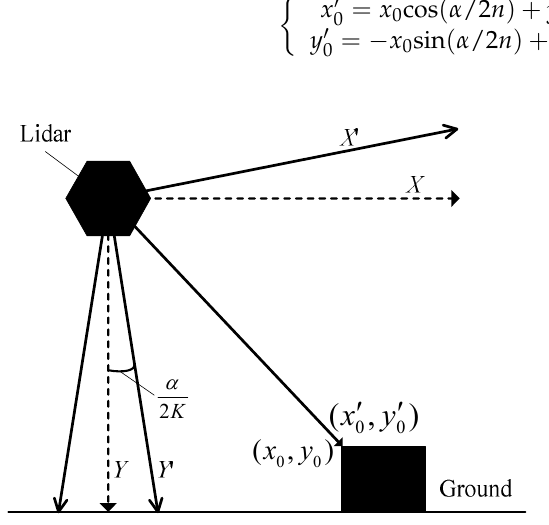
Figure 10. Diagram of maximum calibration error.